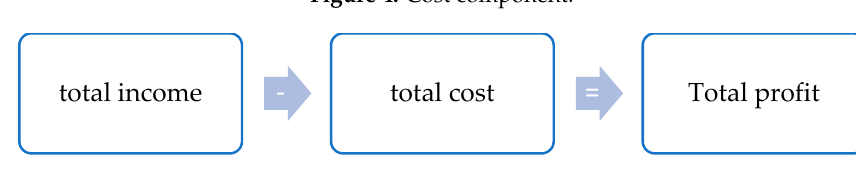
Figure 4. Cost component.